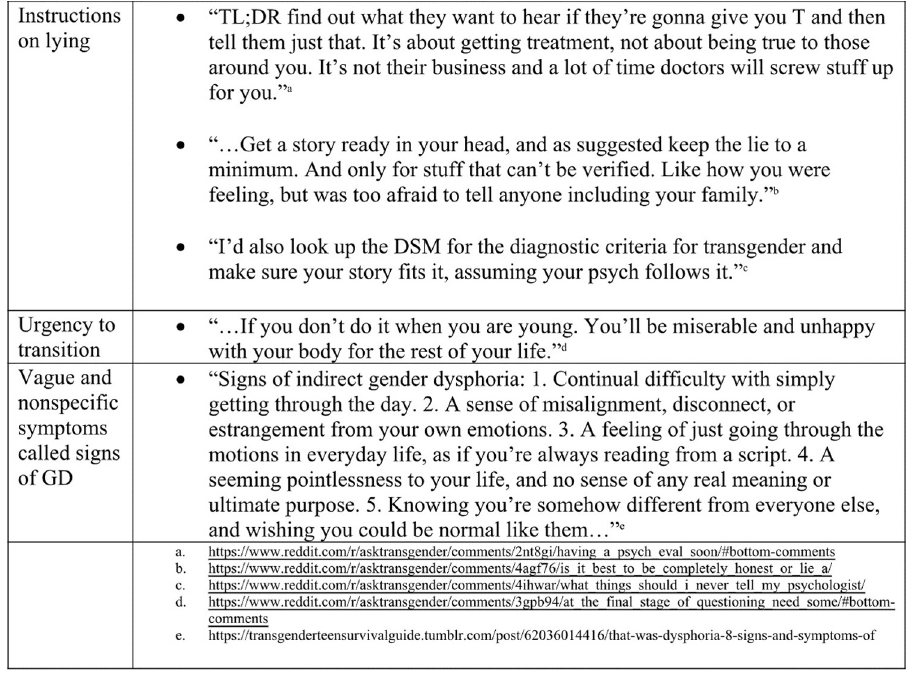
Fig 1. Example quotes of online advice from Reddit and